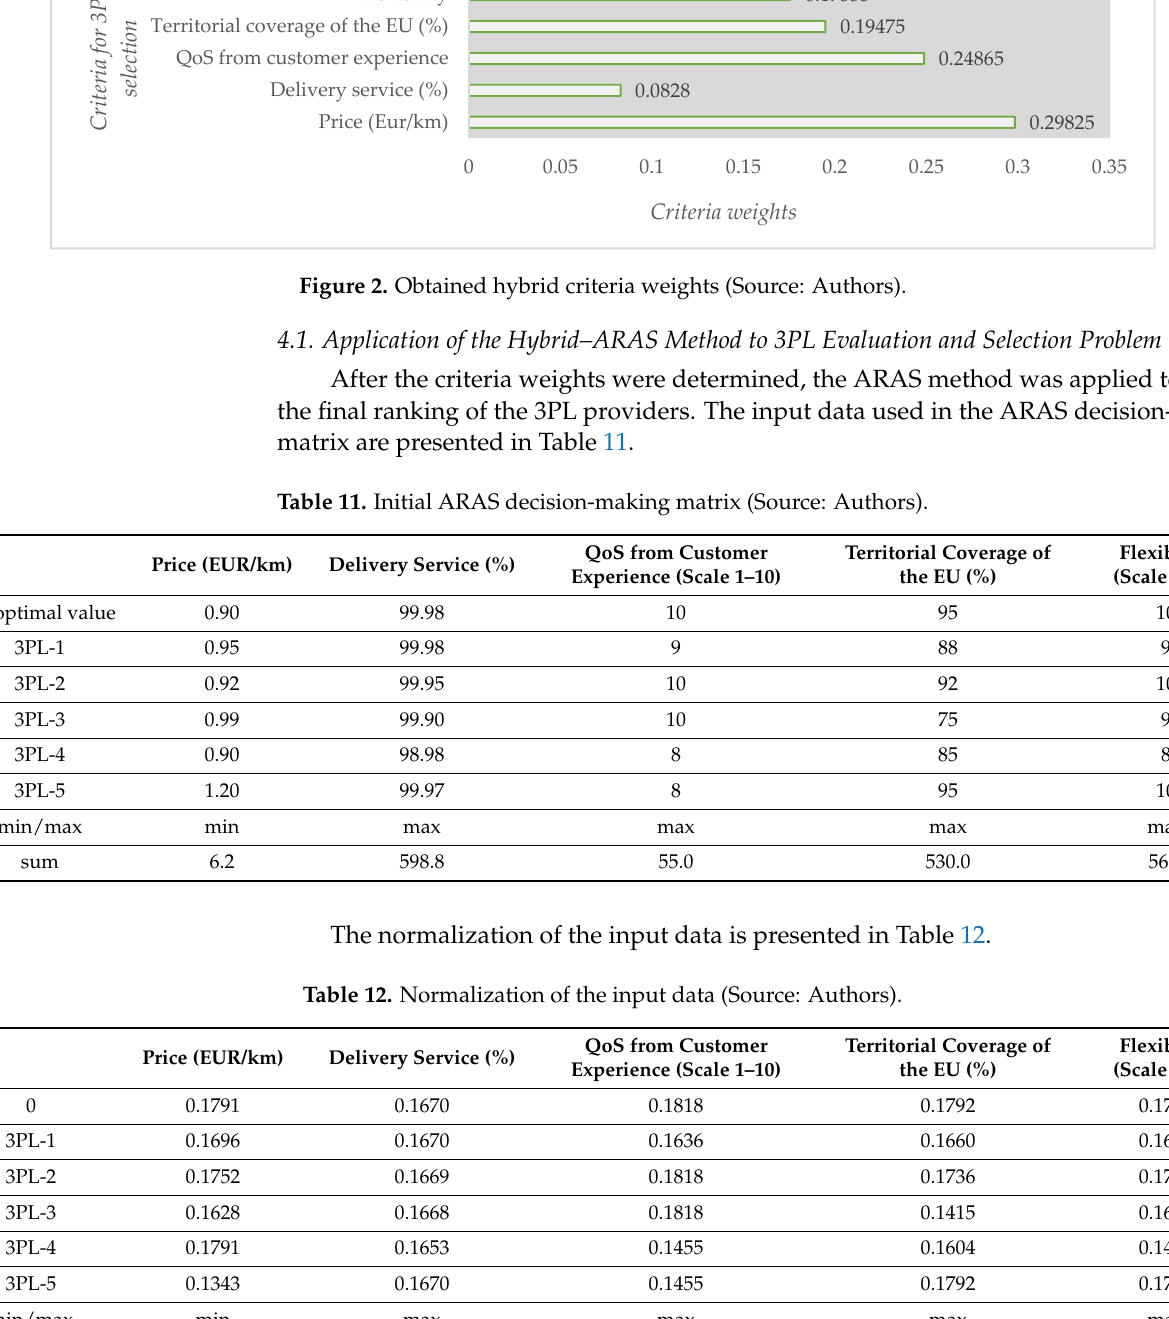
Table 12. Normalization of the input data (Source: Authors).